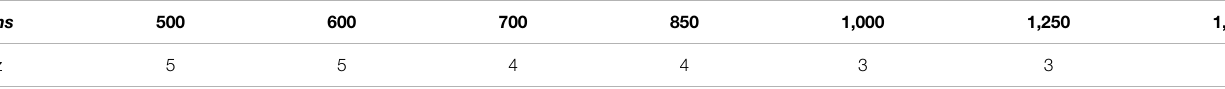
TABLE 2 | Relation between blade number and speci fi c speed.